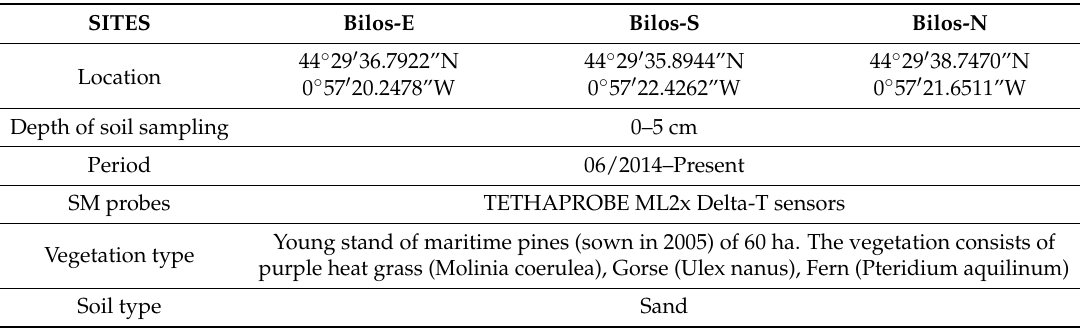
Table 2. The main characteristics of the Bilos sites.